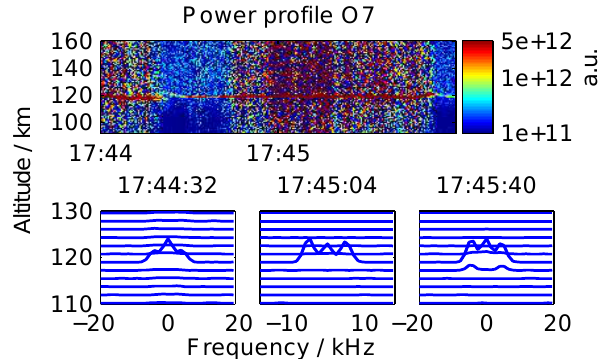
Fig. 6. Same as Fig. 2 for heating cycle O7 (17:44–17:46UT).